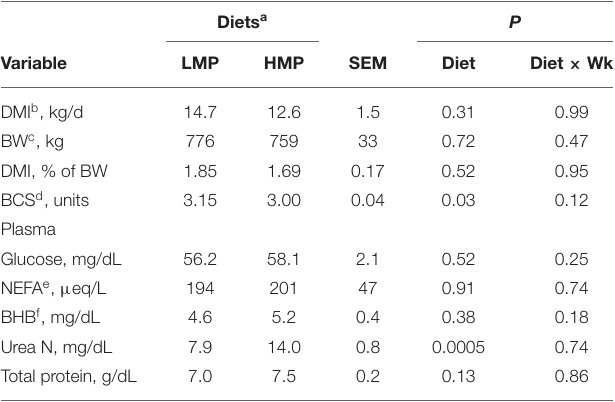
TABLE 2 | Chemical analysis of diets for cows fed low (L) or high (H) amounts of metabolizable protein (MP) prepartum.